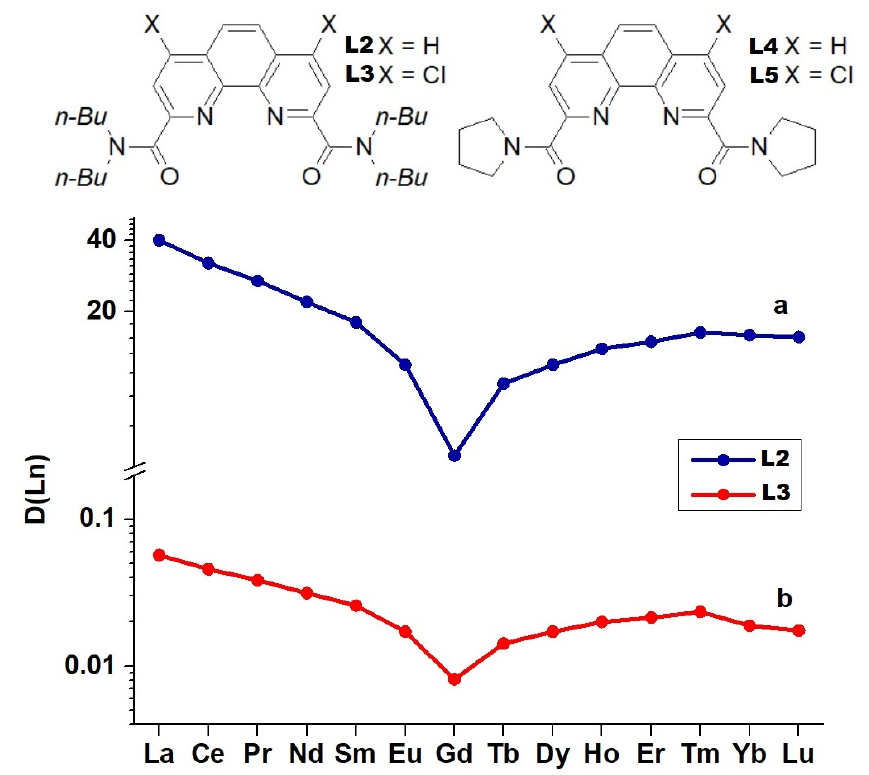
Figure 2. V-shaped dependence D vs. Z observed for Ln extraction by ( a ) 0.5 M L2 from 3 M HNO 3 and ( b ) 0.5 M L3 from 5 M HNO 3 .